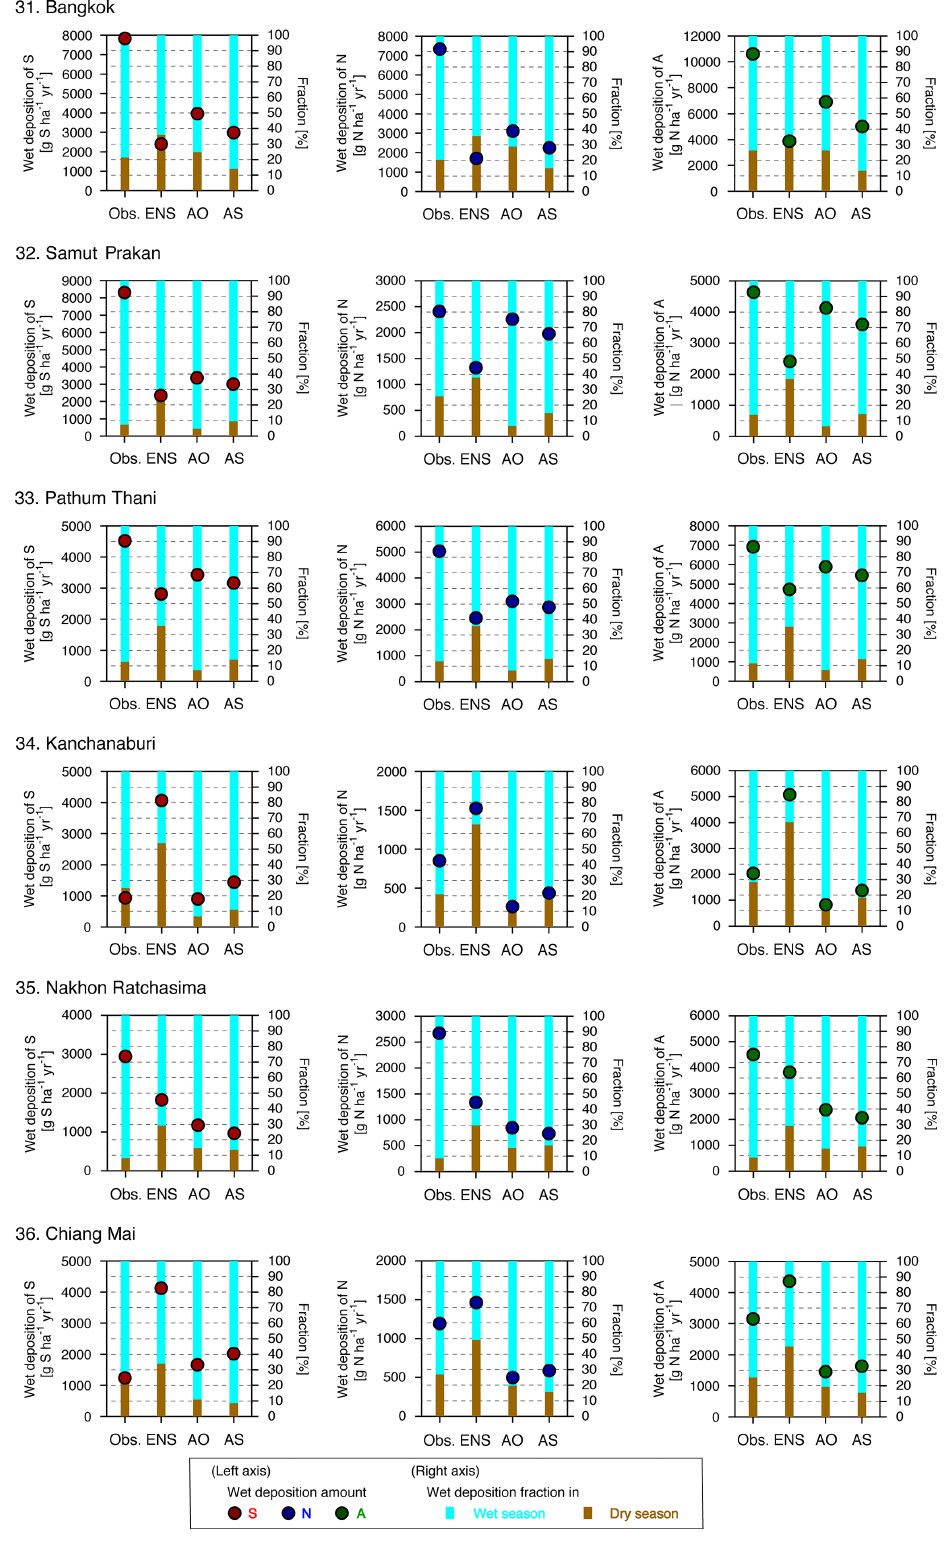
Figure 11. Observed and simulated annual accumulated wet deposition amounts of S, N, and A, and the fraction of wet deposition during the wet and dry seasons at six sites in Thailand. The annual accumulated wet deposition amount is based on the months in which wet deposition observations were available (see Fig.